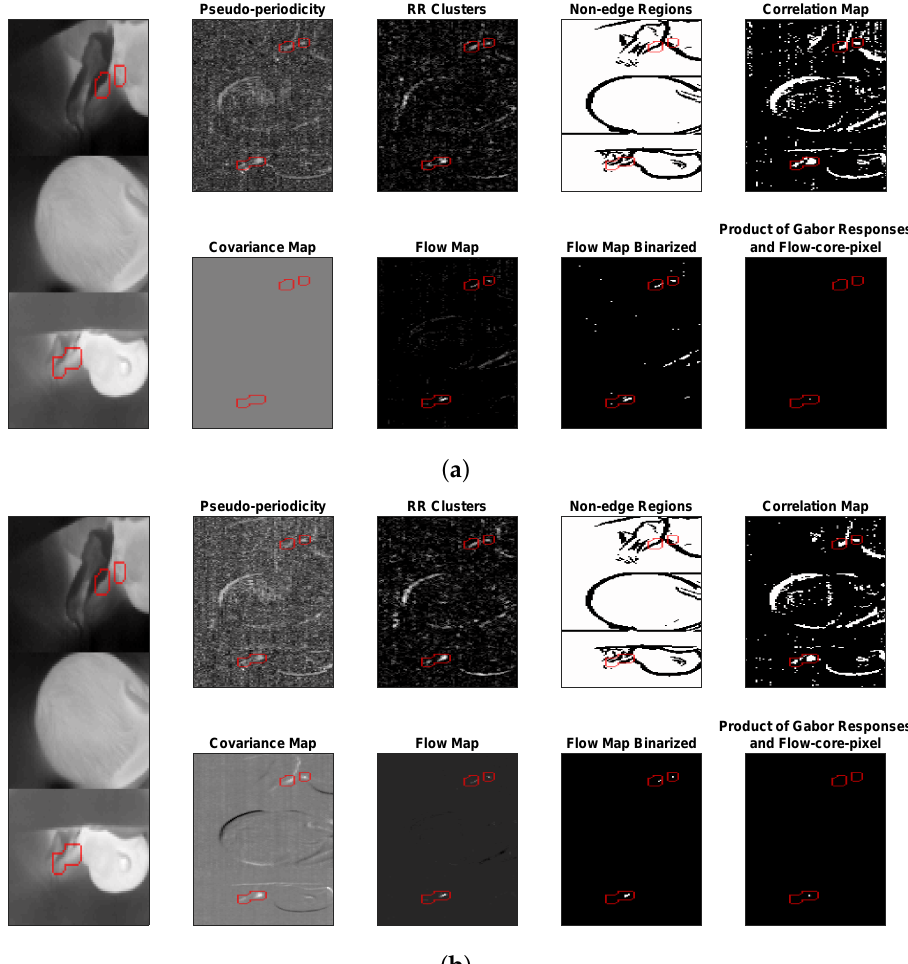
Figure 5. Example of features used for the detection of the RF pixels, the location of the annotated RF pixels is indicated with a red perimeter: ( a ) the features and the choice of the first flow-core-pixel; ( b ) the features used to locate the RF pixels in the next